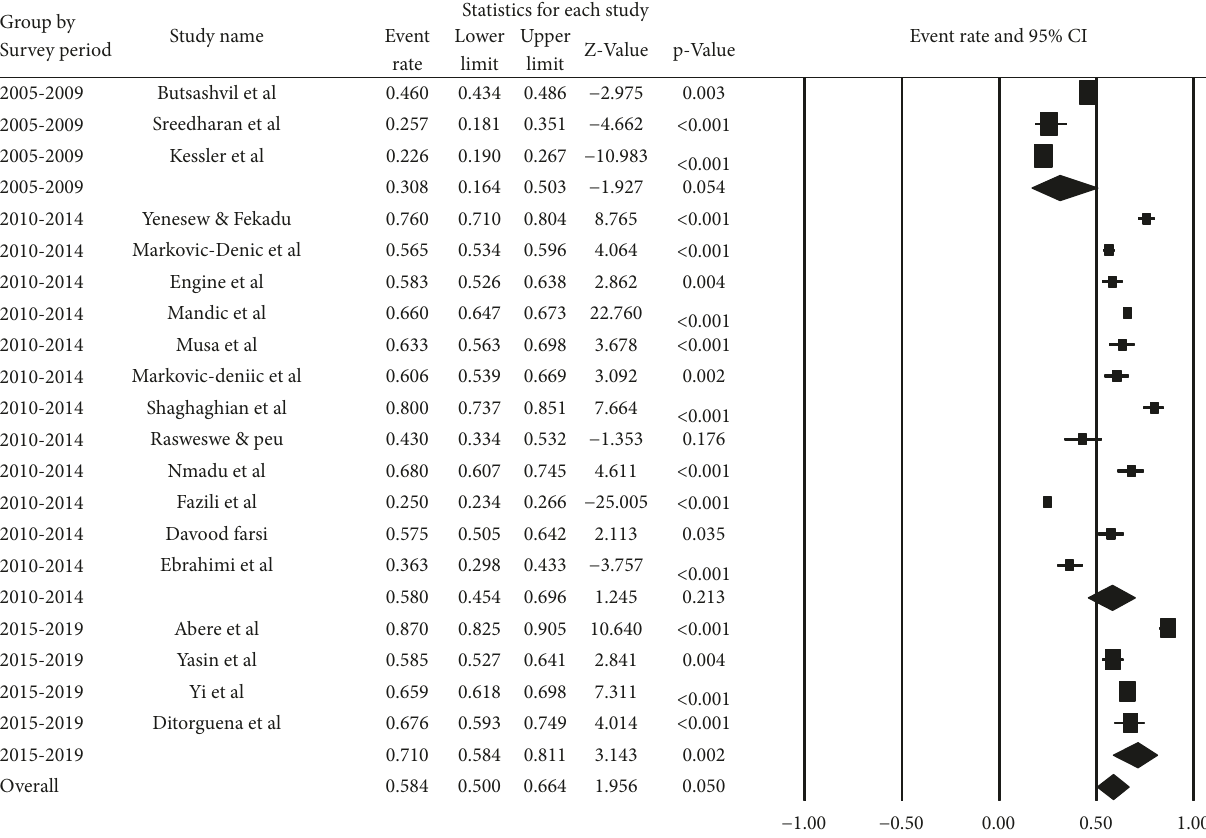
Figure 8: Pooled prevalence of career time occupational exposure to blood and body fluids among healthcare workers based on the survey